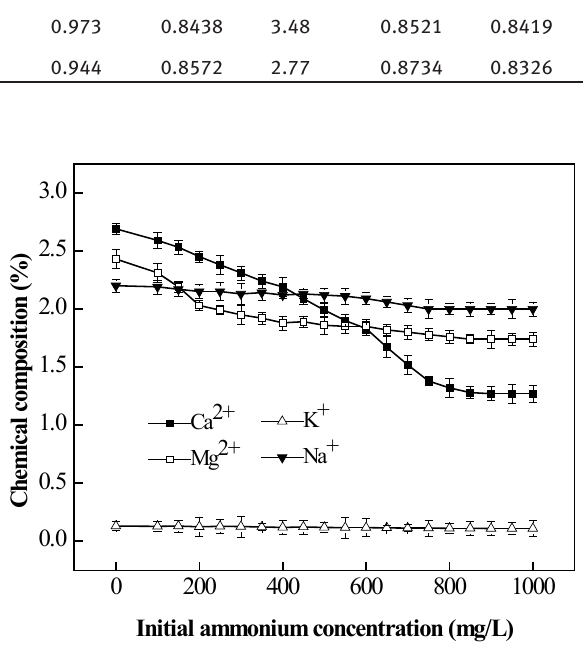
Figure 3: Contents of Ca 2+ , Mg 2+ , Na + and K + of the clinoptilolite after completion of ammonium